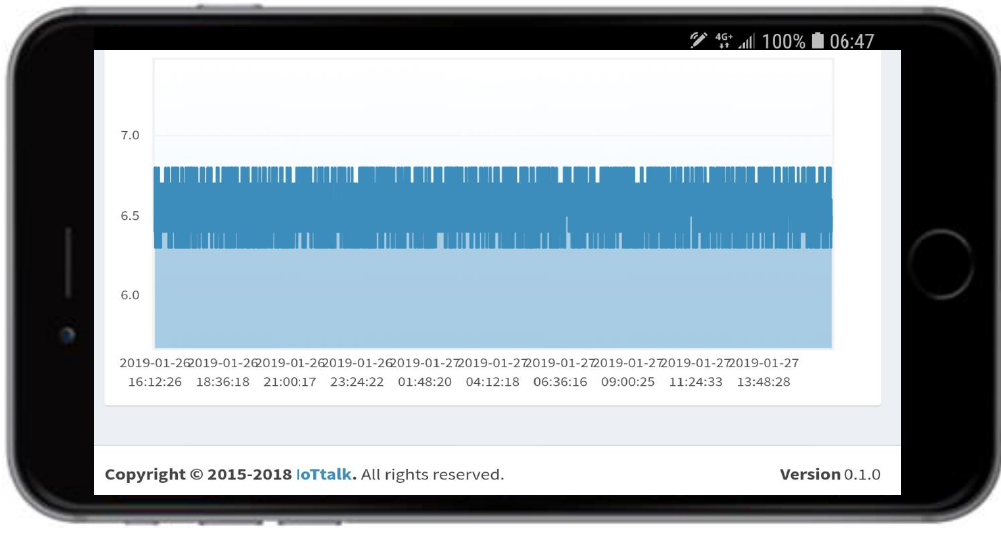
Figure 3. The time series chart for the pH level.